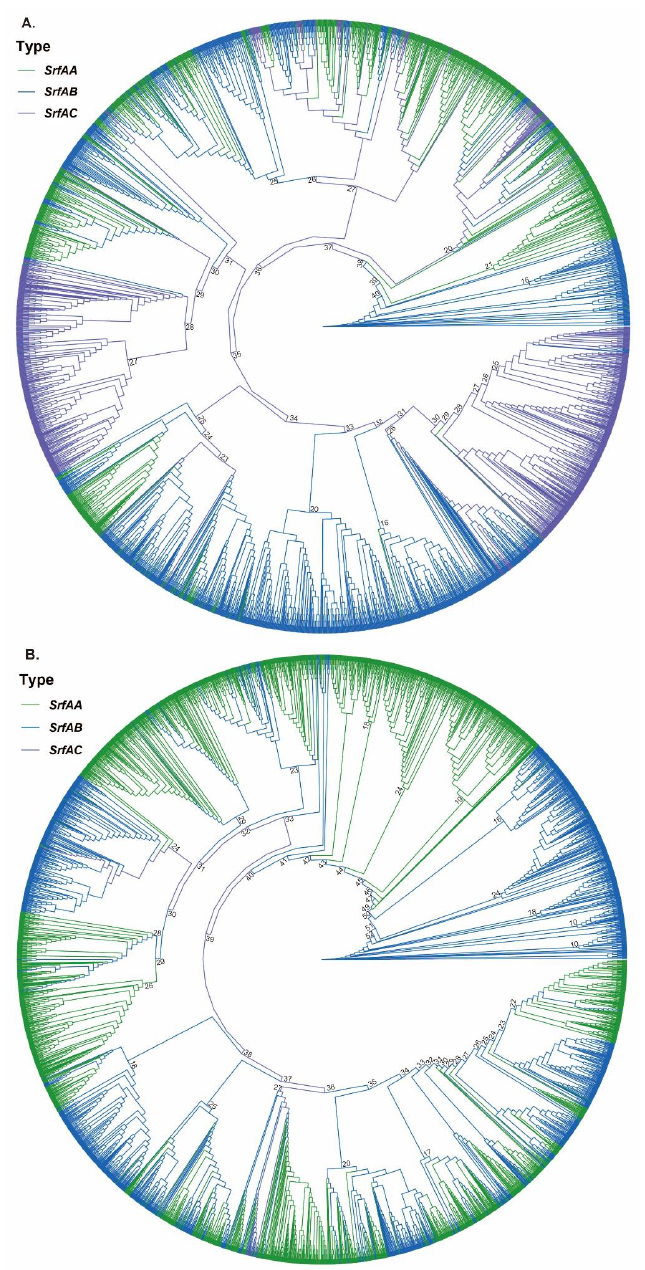
Figure 1. Phylogenetic trees of SrfAA , SrfAB and SrfAC genes in OG0000006 ( A ) and OG0000009 ( B ).